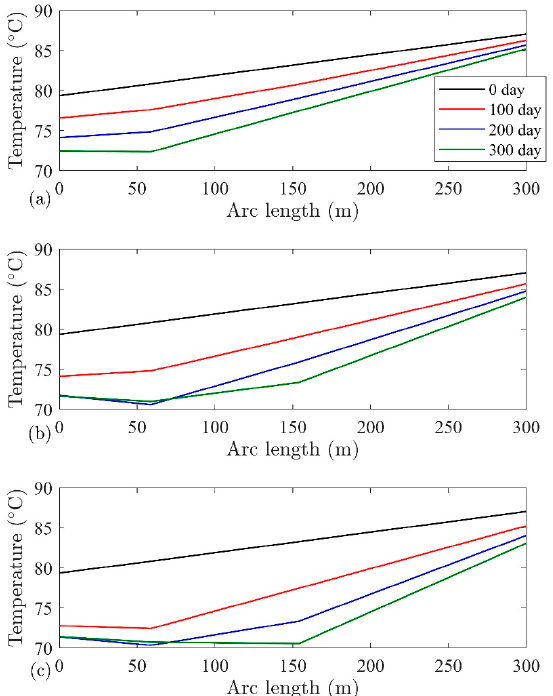
Figure 12. Simulated temperature alongside the open hole section of the injection well UD − 2 for the injection flow rates ( a ) 𝑥 L/s, ( b ) 2 𝑥 L/s, and ( c ) 3 𝑥 L/s. The arc length is measured from the top of the open hole section of the well that falls inside the Porthtowan Fault zone.